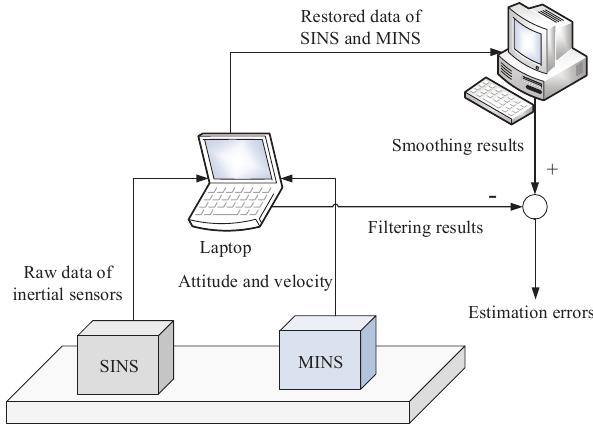
Figure 11. The structure diagram of the van test.